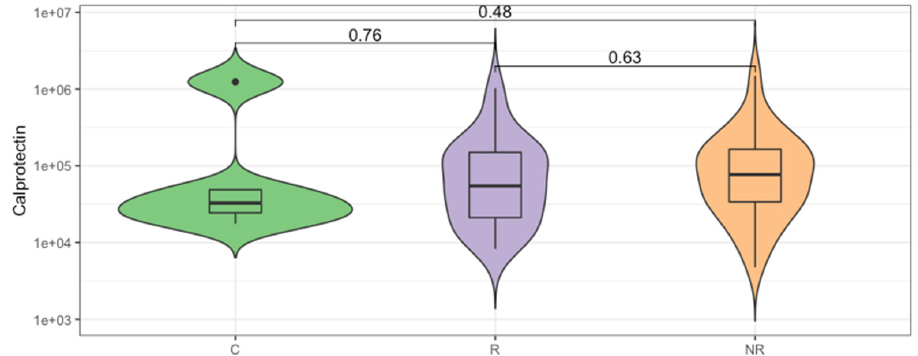
Figure 3. The inflammatory state of gut mucosa was evaluated by calprotectin concentration measurement in the stool of study participants. Comparison between groups of controls (C) and the anti-PD-1 recipients before the first injection of the ICI therapeutics, classified as responders (R) and non-responders (NR) according to the clinical outcome of ICI therapy. The p -values describing the statistical significance of the calprotectin level in the study groups were calculated with Wilcoxon Rank Sum Test. The plot is in a logarithmic scale.